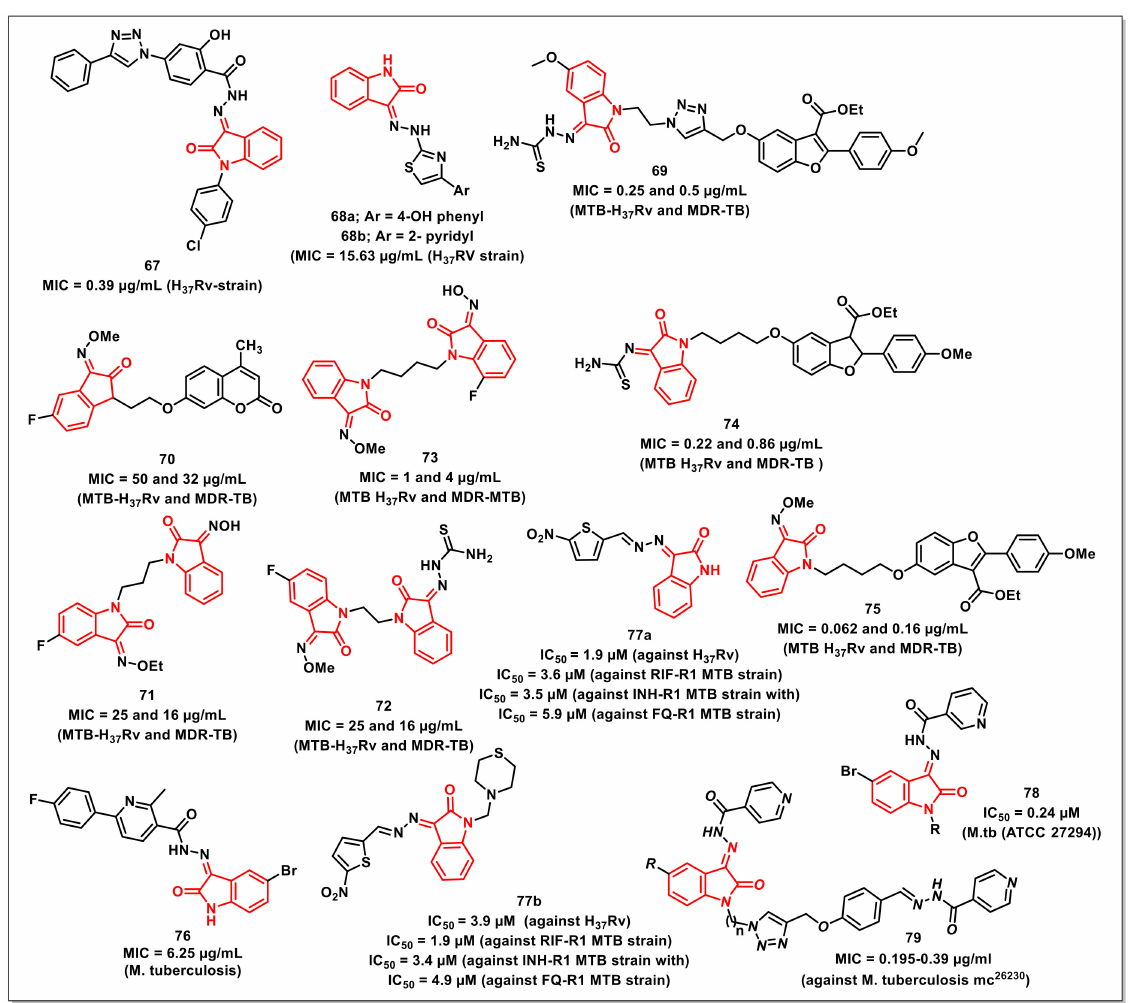
Figure 11. Schiff bases and oximes of isatin with antimycobacterial